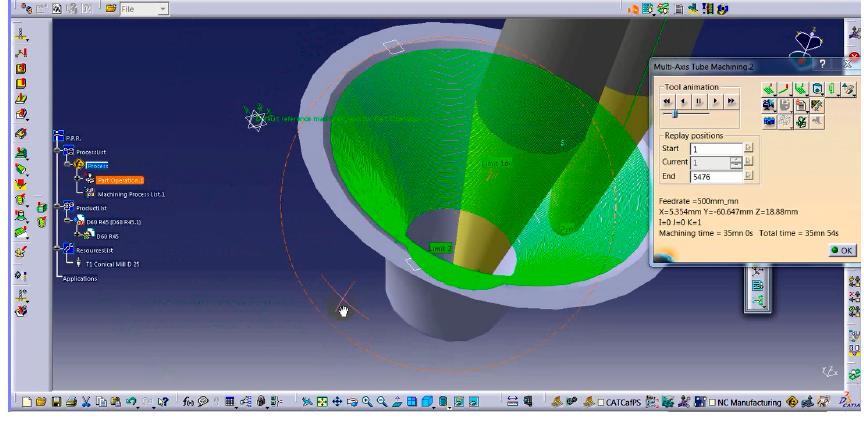
Figure 8. Setting the tool trajectory parameters using CATIA software.